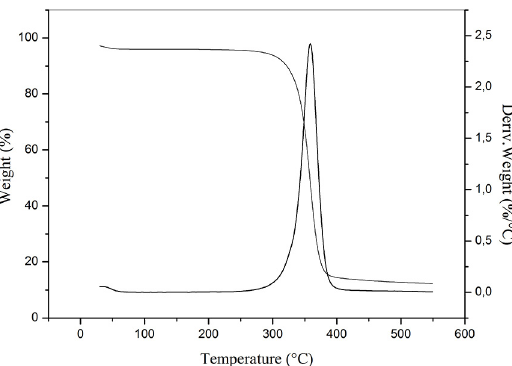
Figure 2: TGA thermogram of methylcellulose.